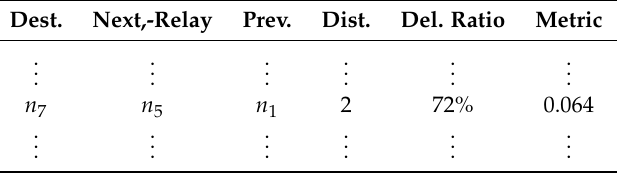
Table 2. Routing Table of n 2 in Figure 3.